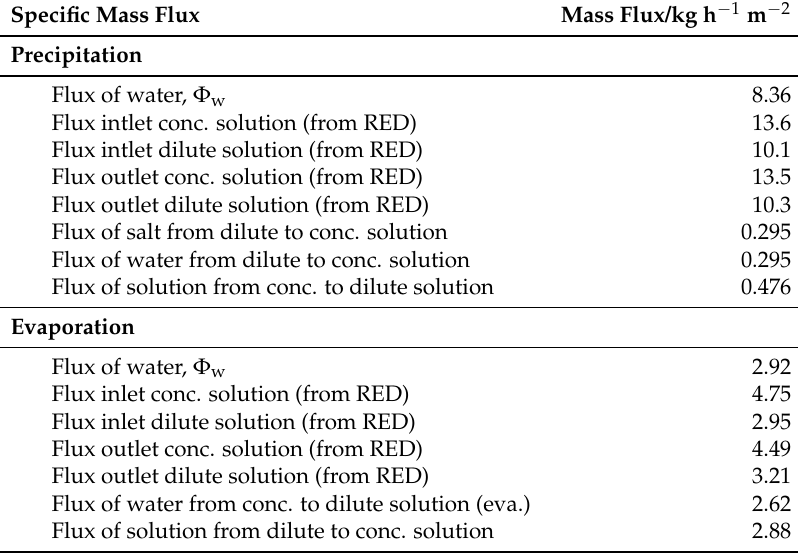
Table 10. Mass fluxes in the two separation systems per cross-section area.